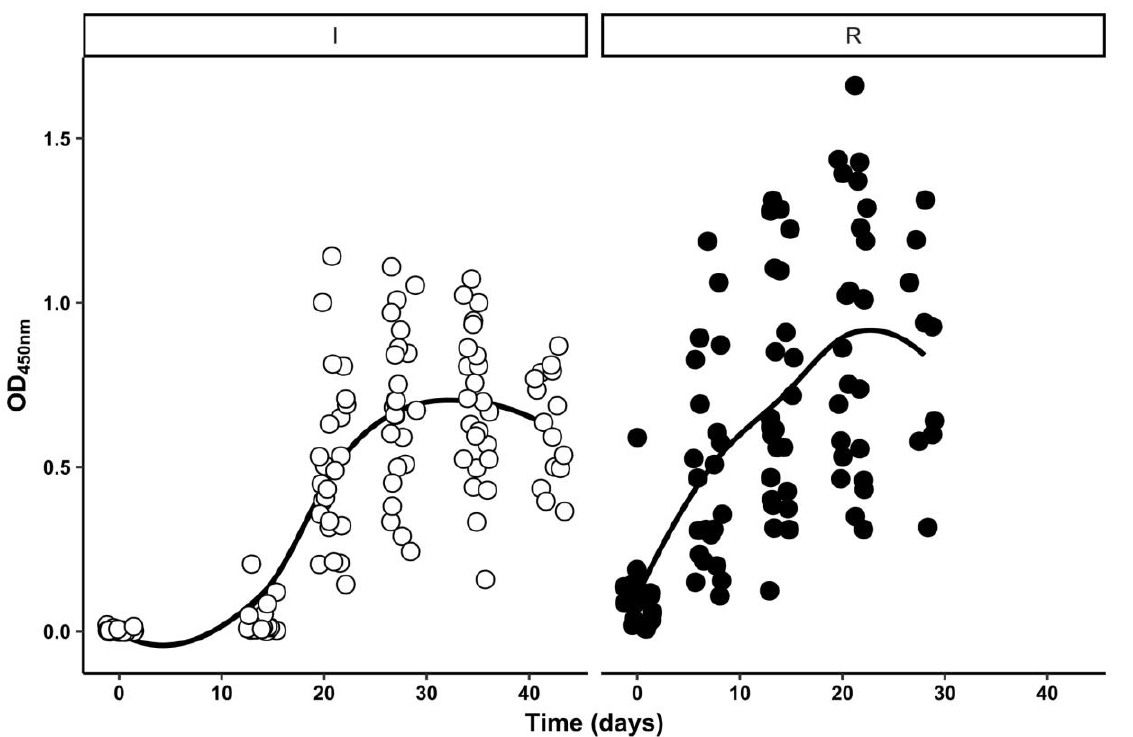
Figure 1. rRBD-specific IgG immune response kinetics in horses’ sera. Blood was extracted from the jugular vein of horses at regular intervals during each immunization cycle. RBD-specific IgG response in sera obtained from these blood samples was estimated by the indirect ELISA technique described in Section 2. Figure 1 displays the level of rRBD-specific IgG response detected (OD 450 nm ) for each sera sample at the different times of extraction (Time). Results of sera obtained during the initial immunization cycle (white circles) and during the following reimmunization cycle (black circles) are represented together with their estimated group means (black